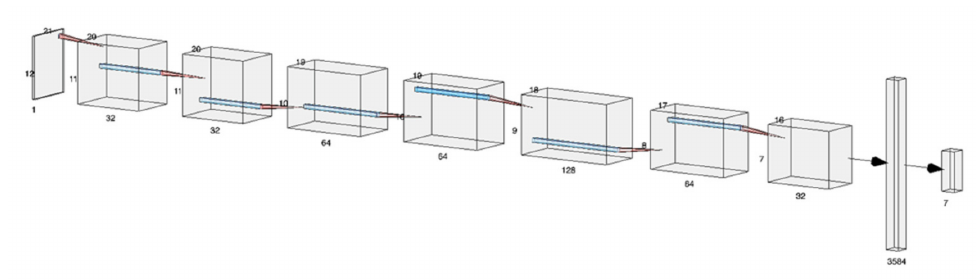
Figure 9. Schematic representation of the different layers of the convolutional network model developed for this project.